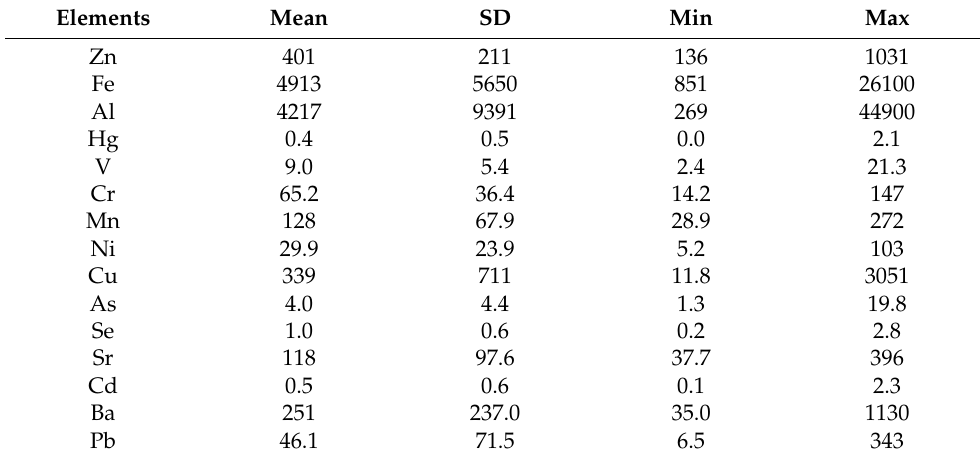
Table 2. Metal concentrations in indoor dust samples ( µ